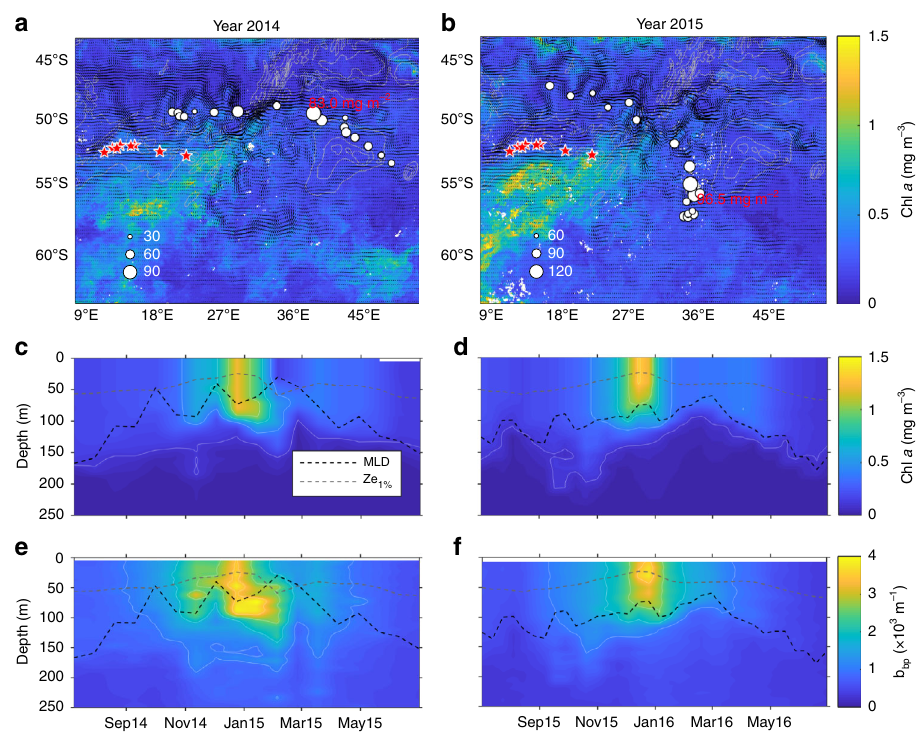
Fig. 2 Massive phytoplankton blooms stimulated by upwelled hydrothermally in fl uenced deep waters along the Southwest Indian Ridge (SWIR). Maps ( a and b ) of the SWIR in the Indian sector of the Southern Ocean and fl oat trajectories. The maximum depth-integrated biomass (mg Chl m − 2 ) is depicted according the size of the circles. Satellite-derived surface chlorophyll a climatologies (8-days GLOBcolour composite products) were retrieved from November to January a 2014 – 2015 and b 2015 – 2016. Black arrows correspond to altimetry-derived geostrophic velocities (AVISO MADT daily product) averaged over the same period. Gray lines represent the 2000, 3000 and 4000 isobaths. Time series of the 0 – 250m vertical distribution of chlorophyll a ( c and d ) and backscattering ( e and f ) for the two BGC-Argo fl oats (WMO 6901585 and 2902130). The black and gray dashed lines are, respectively, representing the mixed layer depth (determined by a density-derived method with a density threshold of 0.03kgm − 3 ) and the euphotic zone depth (de fi ned as the depth of 1% of surface irradiance according Morel et al. 35 ; Eq. 10). The red stars indicate the position of hydrothermal vents from Tao et al. 14